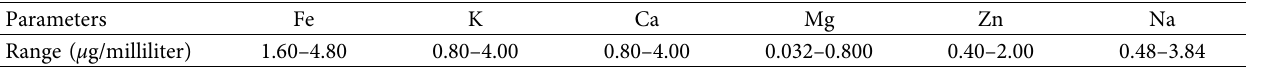
Table 3: The contents of all minerals in W. globosa and their validation